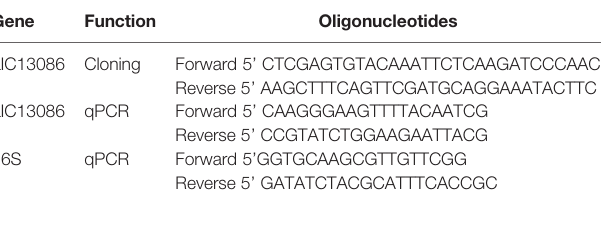
TABLE 1 | Sequence of primers used in cloning and